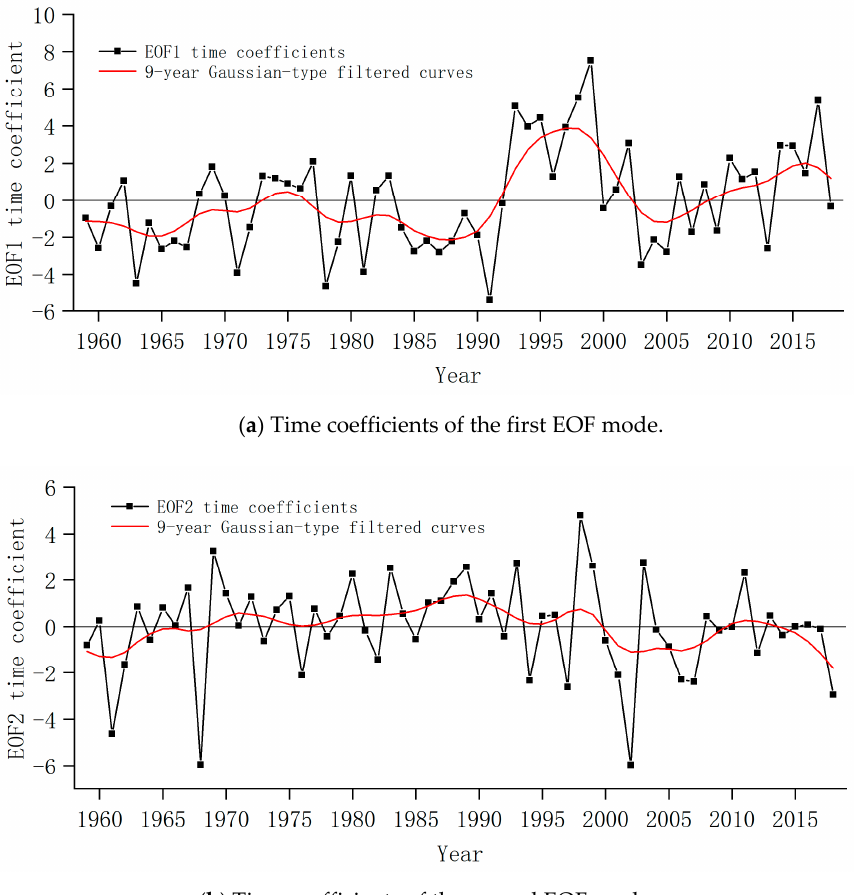
Figure 3. Normalized time coefficient series of the first two leading EOF modes of summer precipitation in the PYLB and 9-year Gaussian-type filtered curves.